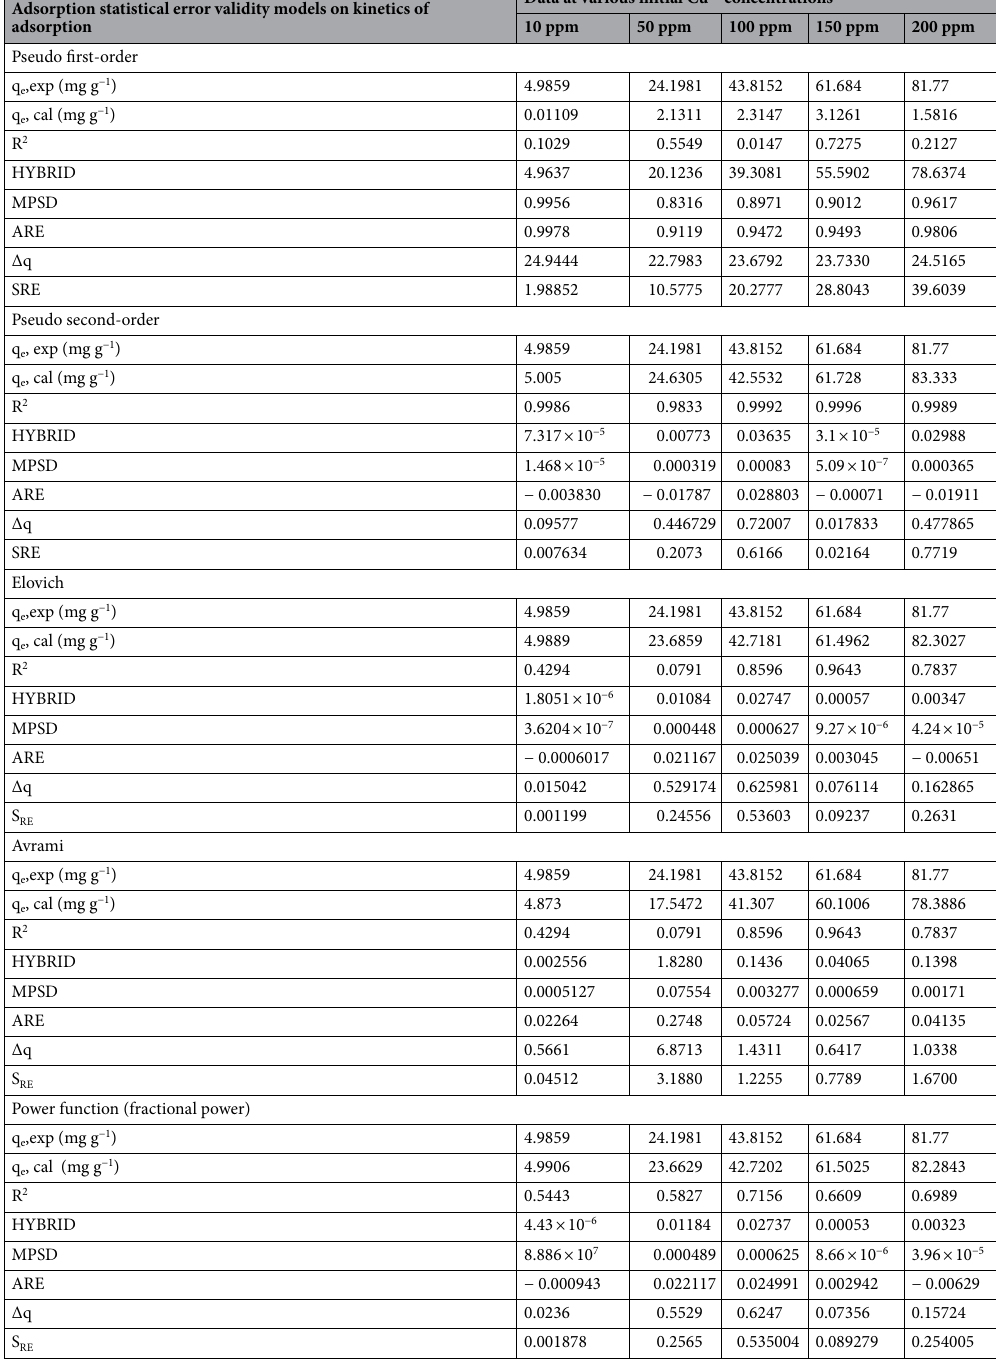
Table 7. Statistical Error validity data on kinetics models of adsorption of Cu(II) onto